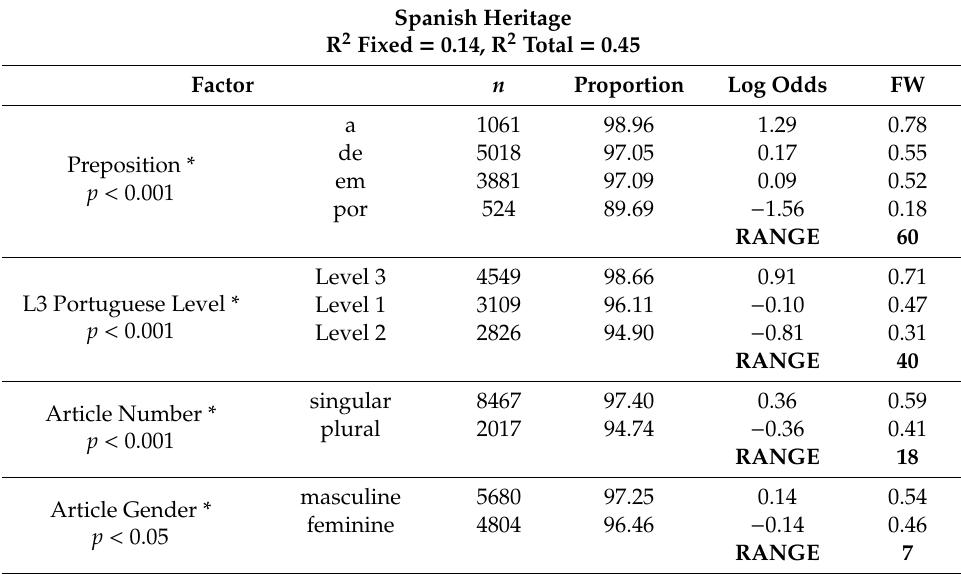
Table 10. Logistic regression of factors conditioning the realization of obligatory preposition + article contraction in L3 Portuguese for Spanish Heritage